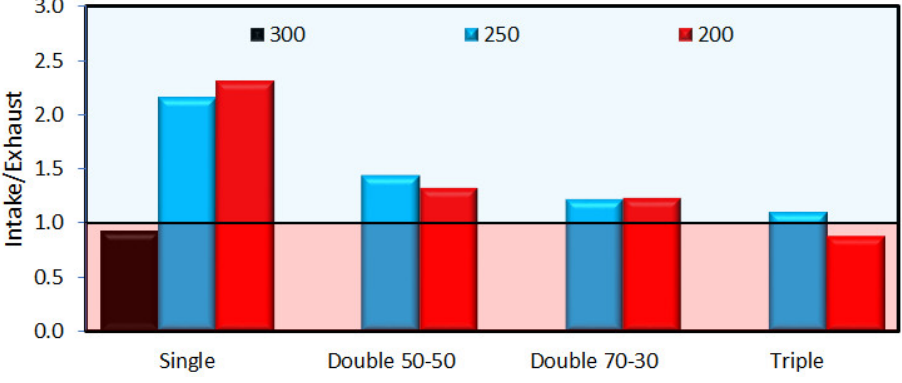
Figure 13 . Preferential flame propagation along the y axis.